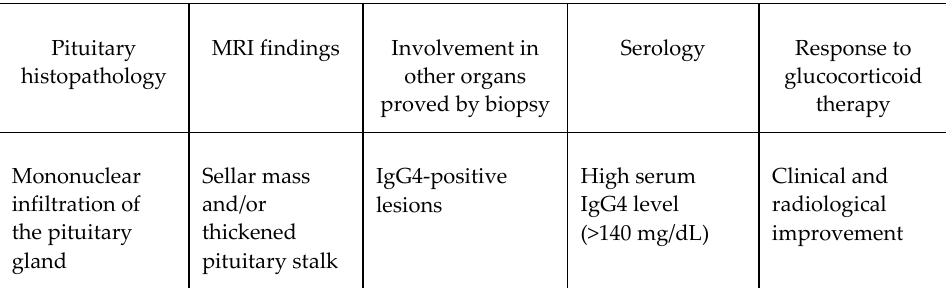
Figure 4. Diagnostic criteria proposed by Leporati et al. [3], modified. Diagnosis is